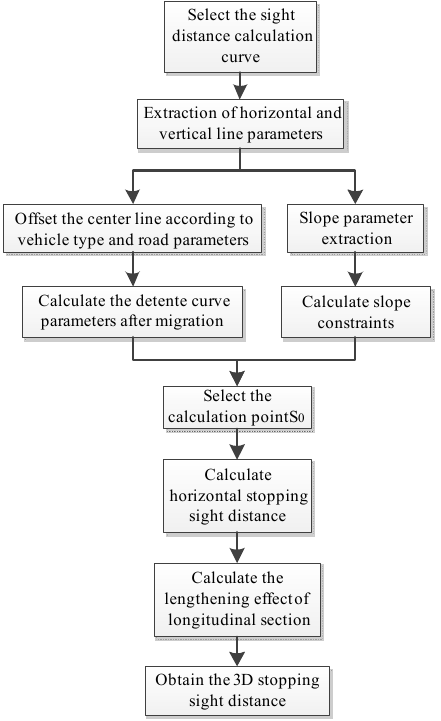
Figure 7. Flow chart of sight distance calculation.